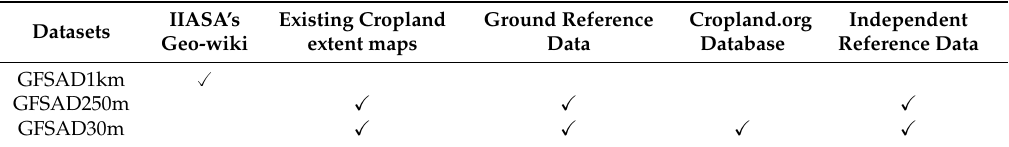
Table 3. Different sources of reference data used to assess the three different GFSAD cropland extent